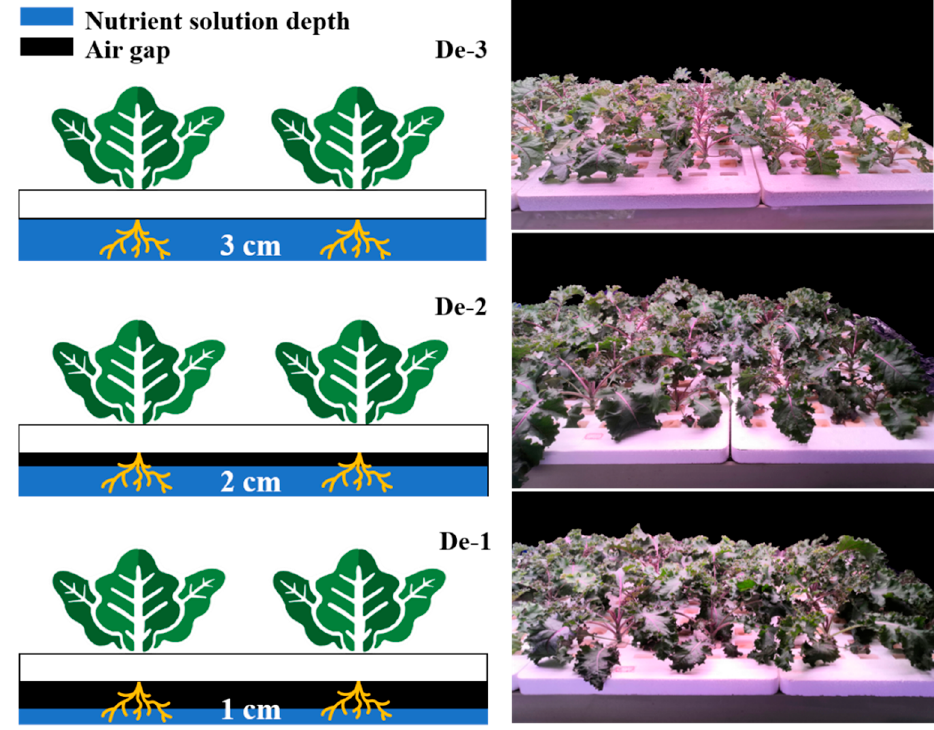
Figure 1. Spectral composition in this study. Different colors represent different wavelengths of light.